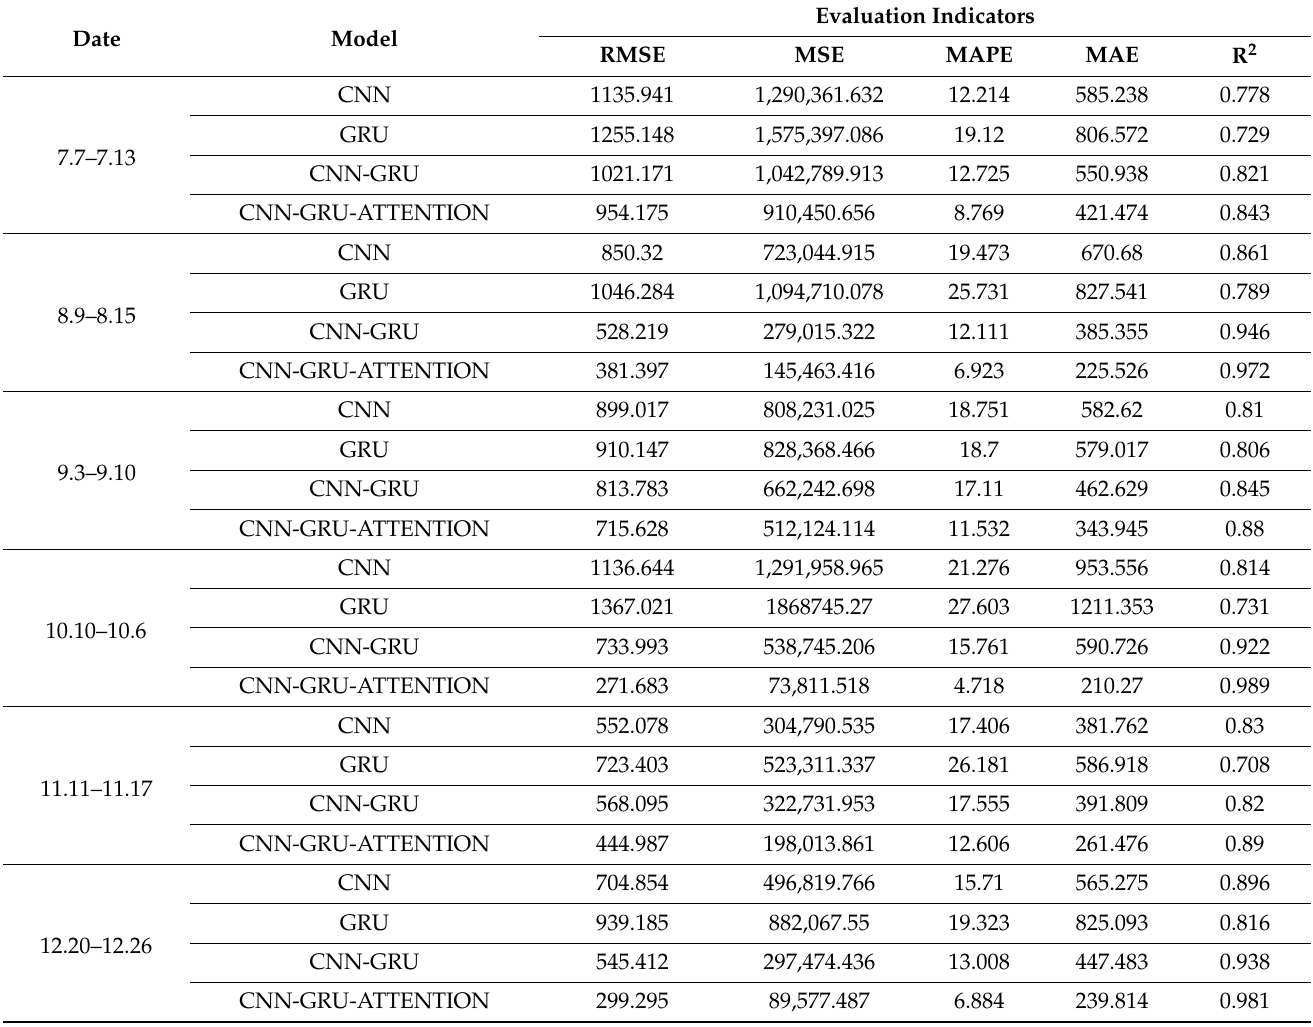
Table 2. Comparison of forecast accuracy by month.